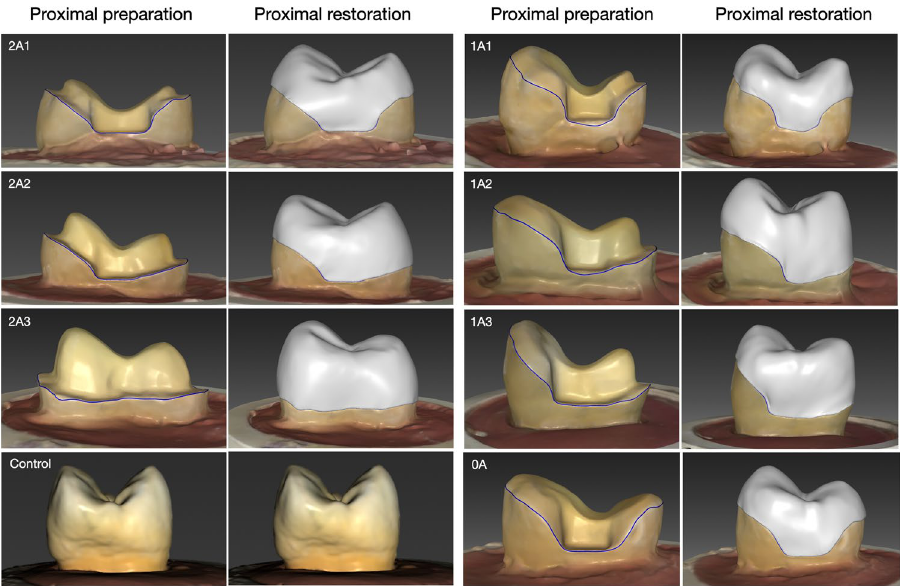
Figure 2. The tooth preparation and the overlay restoration design for each experiment